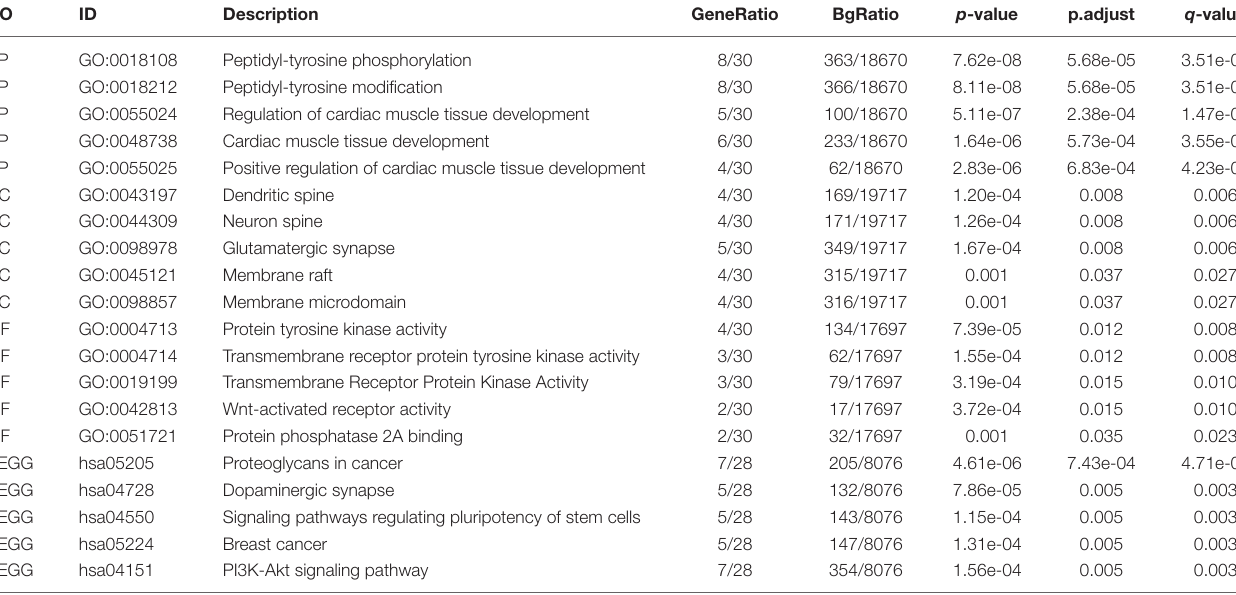
TABLE 3 | The significant GO and KEGG pathways enriched by hub DEMRGs.